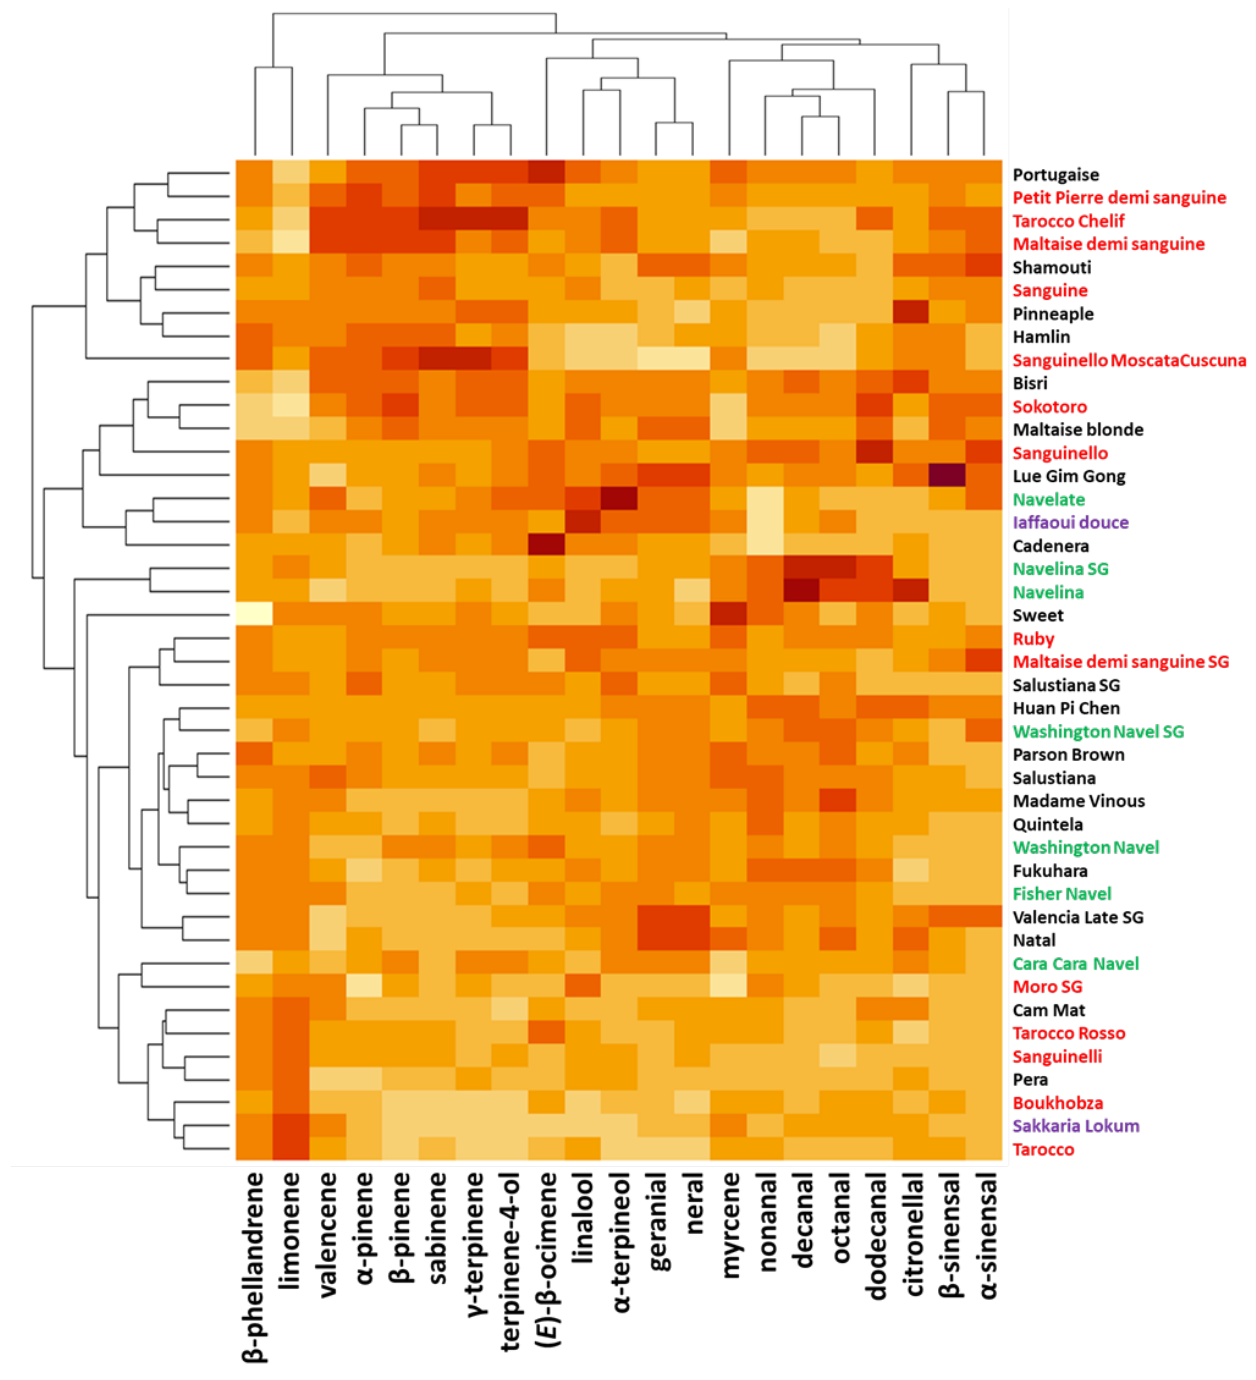
Figure 4. A heatmap representing the diversity of the 43 orange cultivars according to the 20 major peel oil compounds. The color range from yellow to dark red indicates the degree of value of the observed trait in the orange population, respectively, from weak to strong. Bloody cultivars are represented in red, navels in green, acid-free in purple, and classic (blond) cultivars in black.